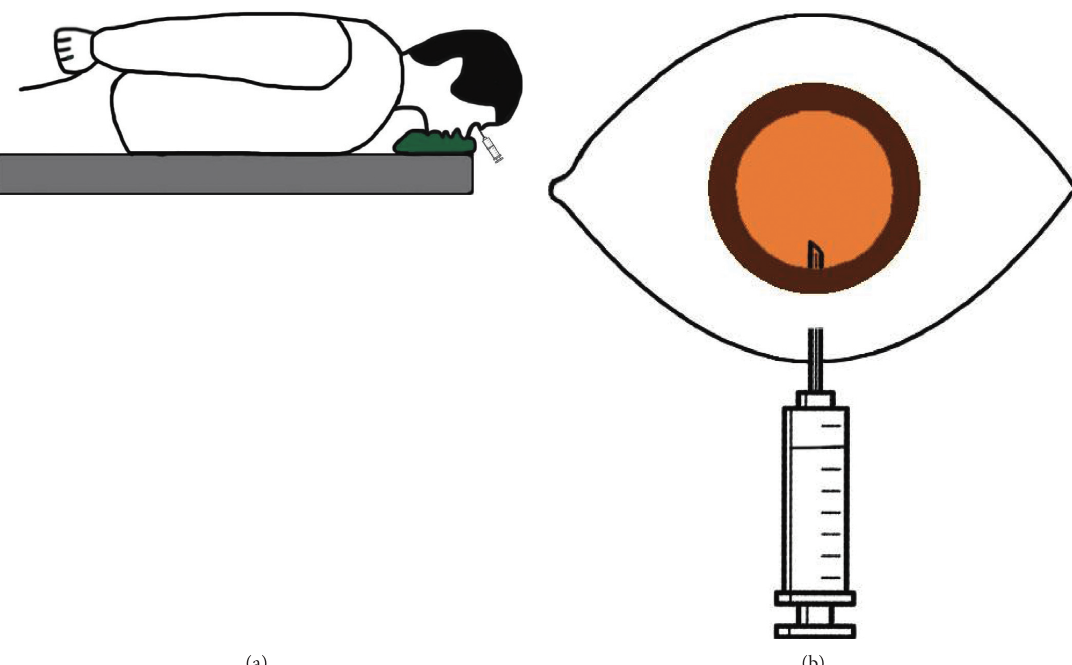
Figure 1: Schematic diagram of “air-liquid exchange by free hand and one needle.” (a) Patient took the prone position; (b) the needle was inserted obliquely at 3.5 mm of the inferior